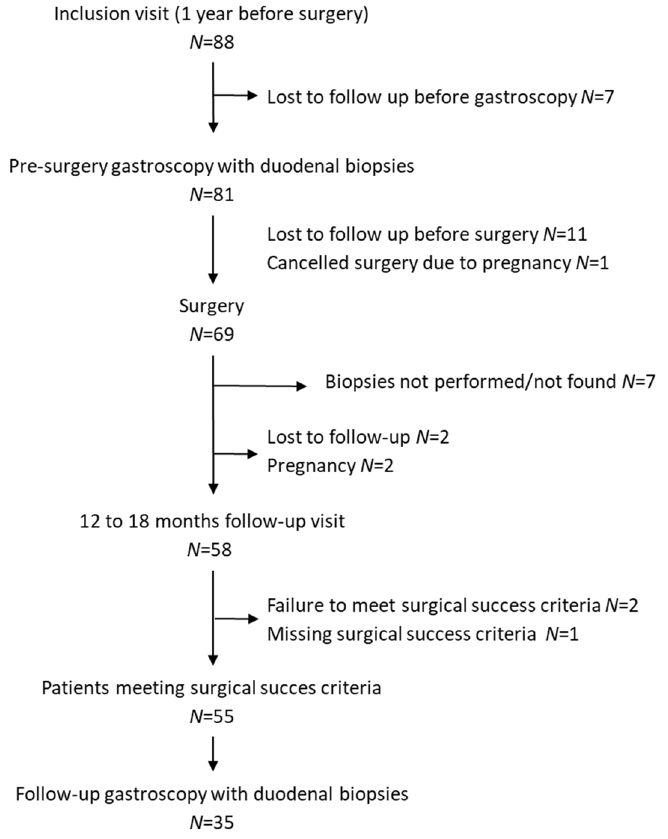
Figure 1. Flow Chart.